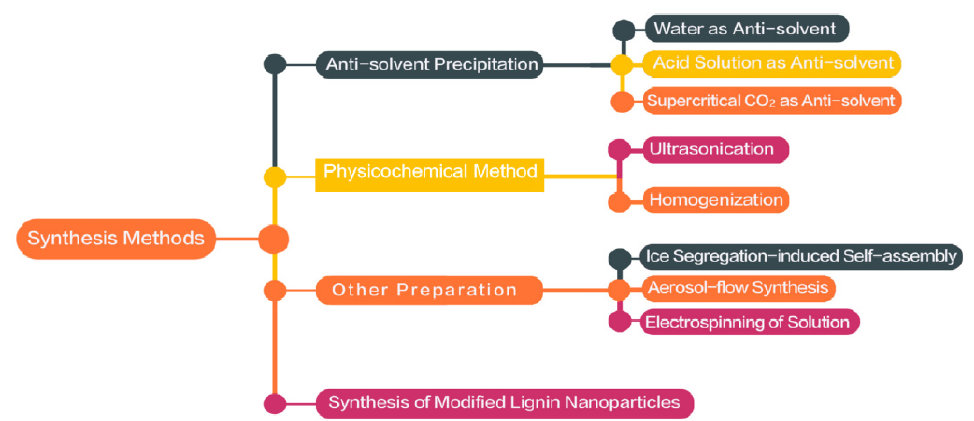
Figure 4. Overview of the synthesis and modification methods of